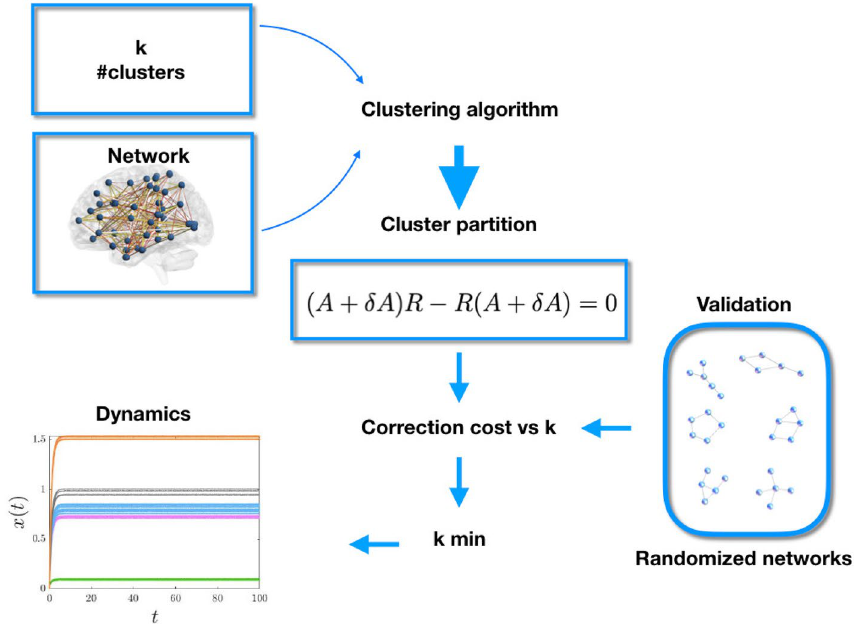
Figure 1. Schematic representation of the method to determine and validate an approximate cluster partition for a network. The clustering algorithm of “Section The case of nearly equitable clusters” is fed with data on a network (in particular, its adjacency matrix) and a given number of clusters, k . This algorithm determines an approximate cluster partition for which we calculate the corresponding projection operator E H . In turn, this is used to calculate δ A from Eq. (6) with R = E H . The correction cost ψ = � δ A � is then contrasted for statistical significance with the result of randomized graphs obtained from the original network, swapping the